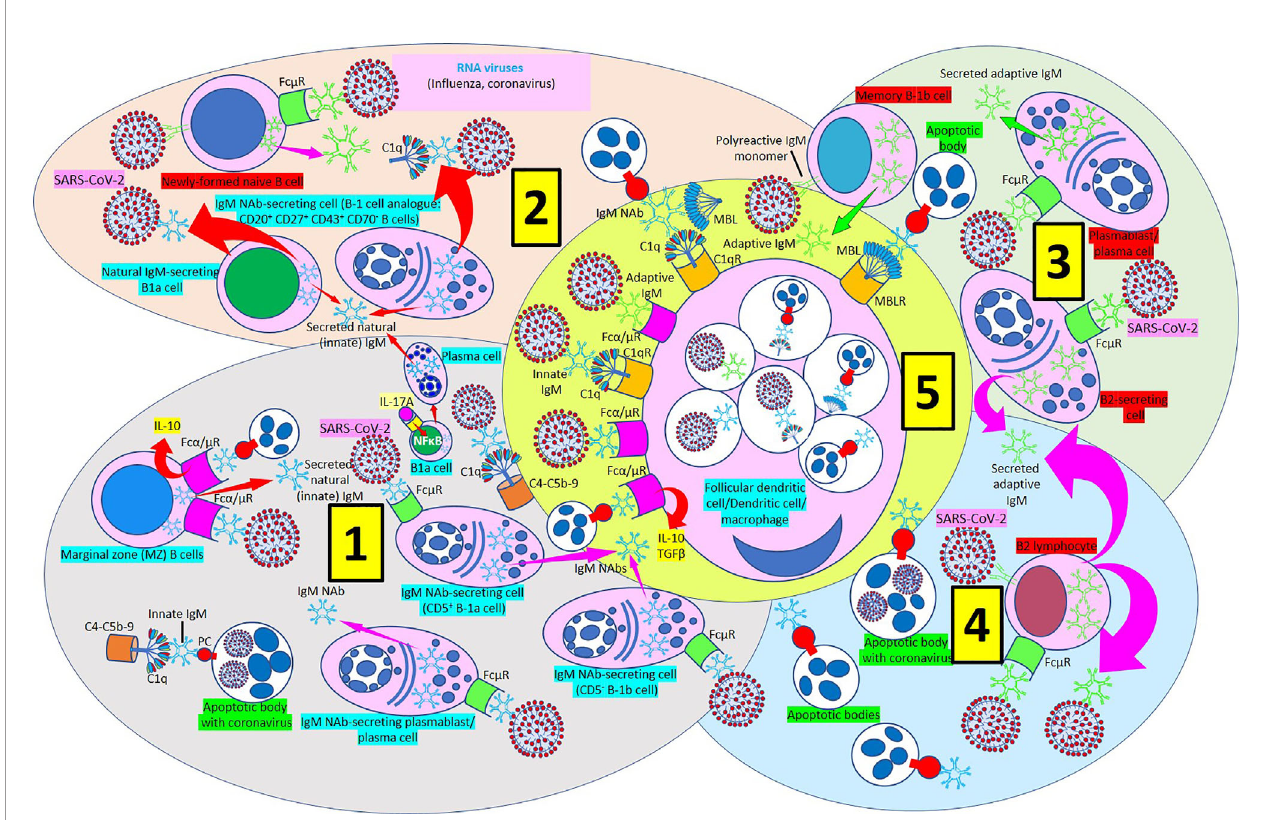
FIGURE 9 | IgM-mediated immune response in coronavirus infection. [1] Most of natural (innate) immunoglobulin M (IgM) natural antibodies (NAbs) are secreted by B-1 cells (CD5 + B-1a and CD5 - B1b) without previous exposure to any antigen or pathogen. B-1a cells are critical in early protection during in fl uenza infections through their IL-17A-driven differentiation into high-rate natural IgM producing plasma cells. Marginal zone (MZ) B cells can recognize IgM NAbs bound to RNA viruses and apoptotic cells through Fc a / m receptors (Rs) and enhance interleukin-10 (IL-10) release. Innate IgM Nab-secreting cells (CD5 + B-1a and CD5 - B1b cells; plasmablasts/plasma cells) recognize virus-bound IgM NAbs through membrane Fc m Rs. Innate IgM NAbs facilitate lysis of viruses and virus-infected apoptotic cells through activation of the complement cascade (C1q-C5b-9). [2] Natural IgM-secreting B1a cells and human B1 cells, identi fi ed in the umbilical cord and in adult peripheral blood and expressing the novel CD20 + CD27 + CD43 + CD70 - phenotype contribute to natural (innate) IgM secretion. Polyreactive IgM monomers on B cells (newly formed naïve B-cells, memory B1b cells) bind repetitive antigenic determinants on bacteria and viruses and induce immune (adaptive) antibody production without the involvement of T-cells. [3] Immune (adaptive) IgM are produced by adaptive B2 cells following exposure to an antigen or pathogen. B2-secreting cells and plasmablasts/plasma cells can produce immune IgM following antibody recognition by Fc m Rs. [4] B2 lymphocytes can secrete adaptive IgM antibodies following virus recognition by membrane IgM monomers and Fc m R recognition of virus bound IgM. [5] Follicular dendritic cells, dendritic cells and macrophages can phagocytose viruses and apoptotic cells bound to innate or adaptive IgM through Fc a / m Rs and C1qRs and enhance IL-10 and transforming growth factor (TGF) ß release to reduce in fl